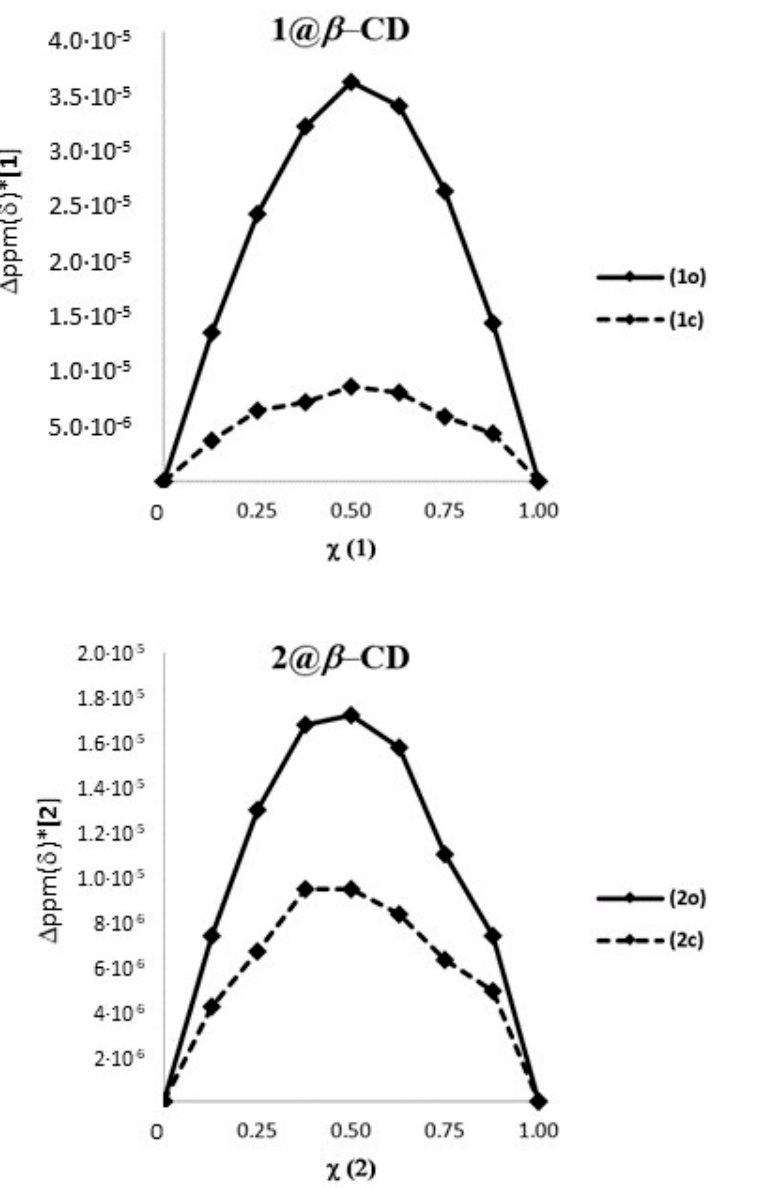
Figure 2. Job plots of 1o-c and 2o-c in the presence of β